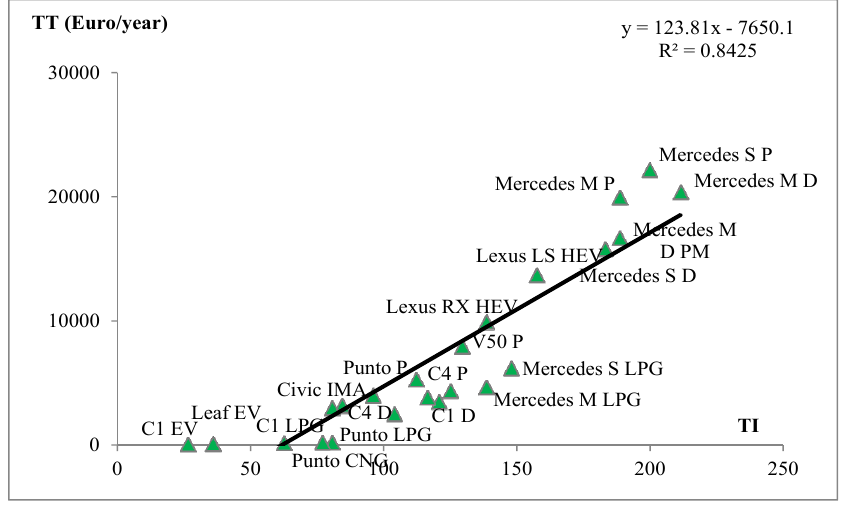
Figure 6. Total taxes (TT) and total environmental impact (TI) of vehicles in Ecoscore-based fiscal system.